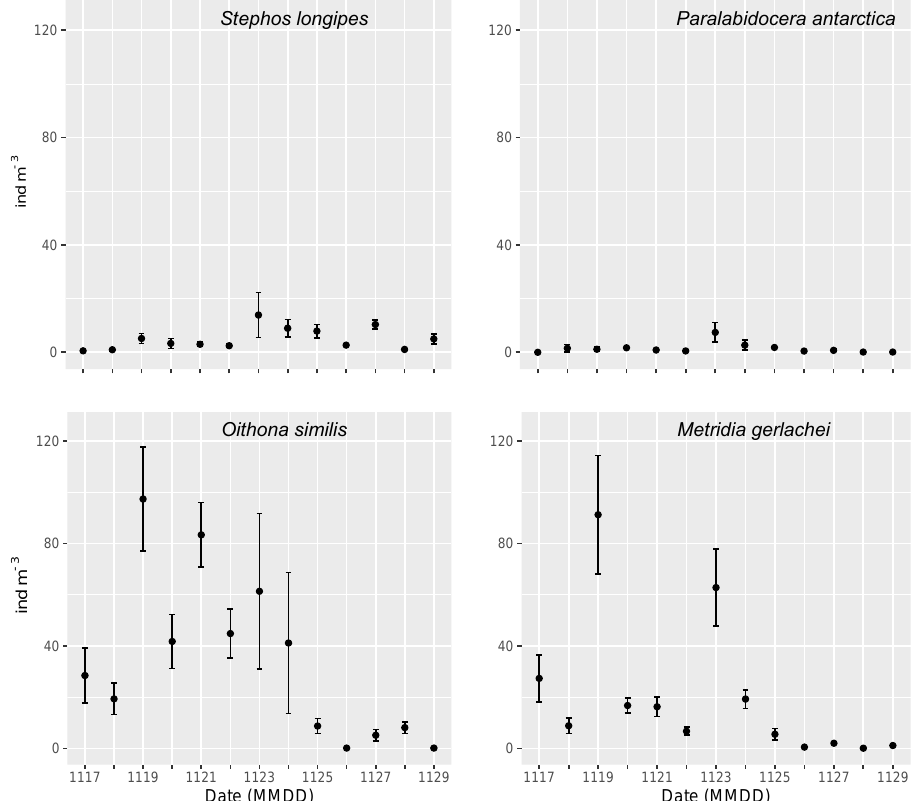
Figure 7. PIPEX 97 cruise, Terra Nova Bay, Antarctica 1997. Trends in abundance (ind m − 3 ) of the main ice-related ( S. longipes , upper left and P. antarctica , upper right) and pelagic ( O. similis , lower left and M. gerlachei , lower right) copepod species. Mean + s.e. values are shown.